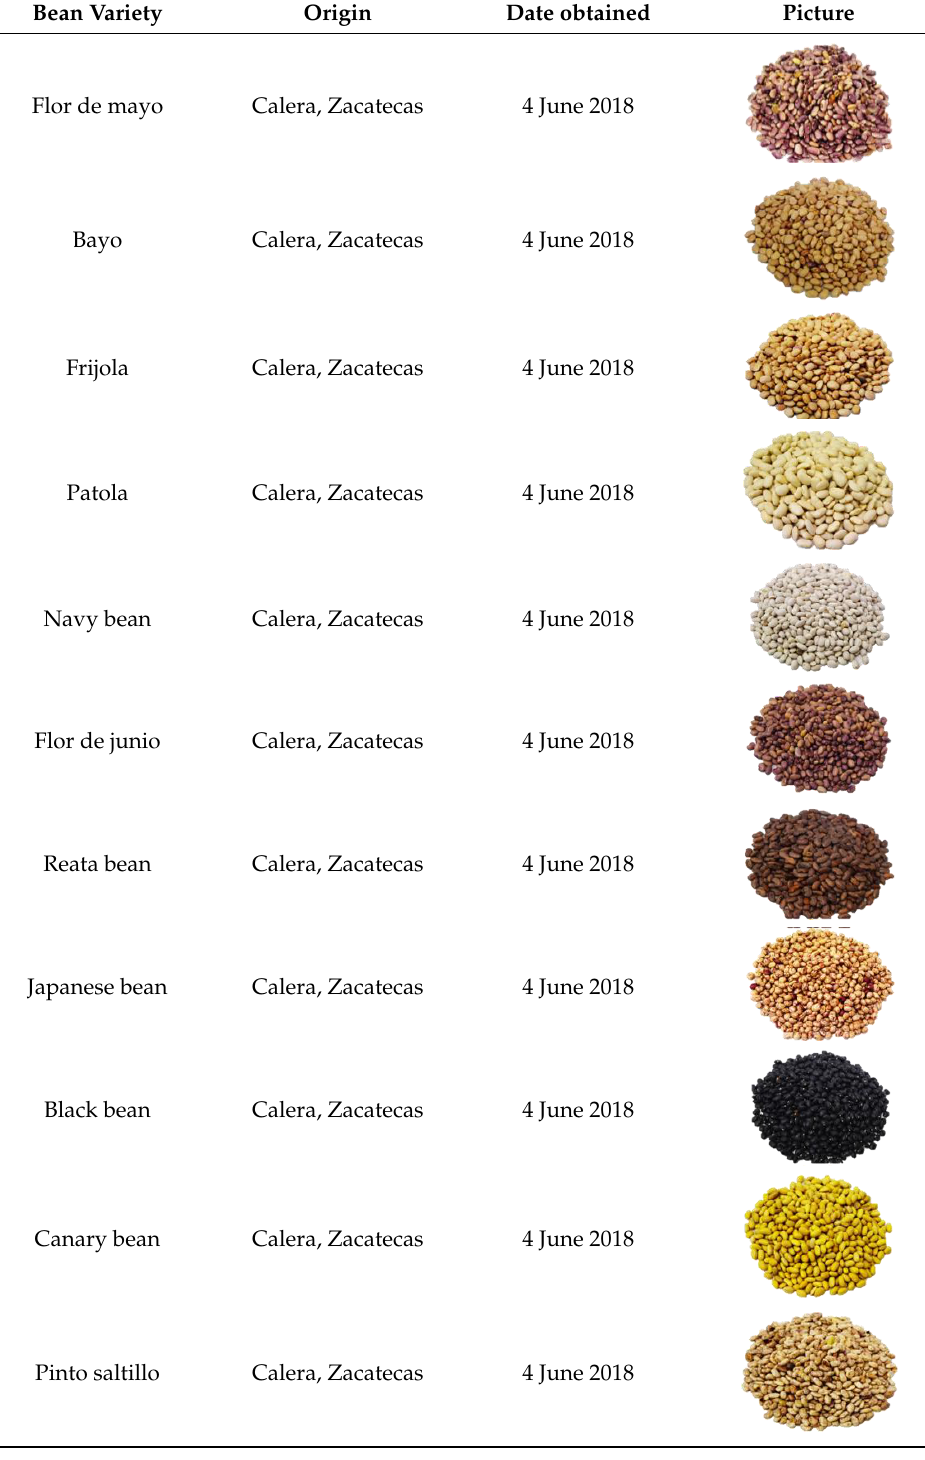
Table 1. Bean varieties selected in the state of Zacatecas to be studied.